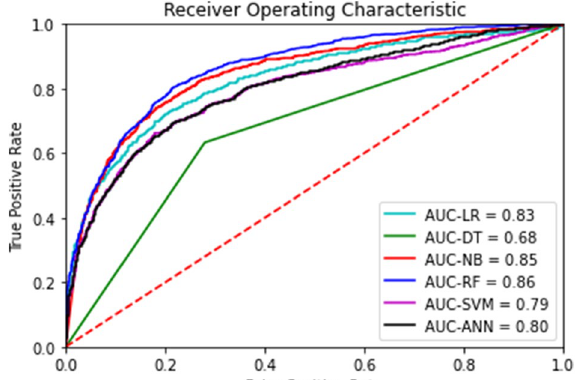
Figure 1. Area Under the Receiver-Operating-Characteristic Curves for Necrotizing Enterocolitis. Legend: The area under the receiver-operating-characteristic curve (AUC) is the plot of the true positive rate (sensitivity) against the false positive rate (1- specificity) at various threshold settings. Abbreviations: ANN Artificial neural network, AUC Area under the receiver-operating-characteristic curve, DT Decision tree, LR Logistic regression, NB Naïve Bayes, RF Random forest, SVM Support vector